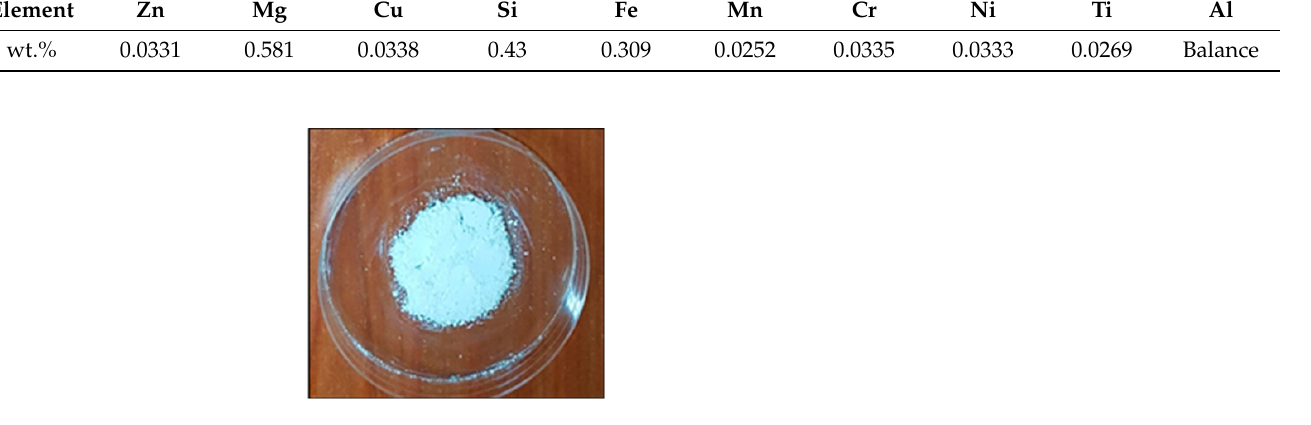
Table 1. Chemical composition (wt.%) of recycled AA 6063.